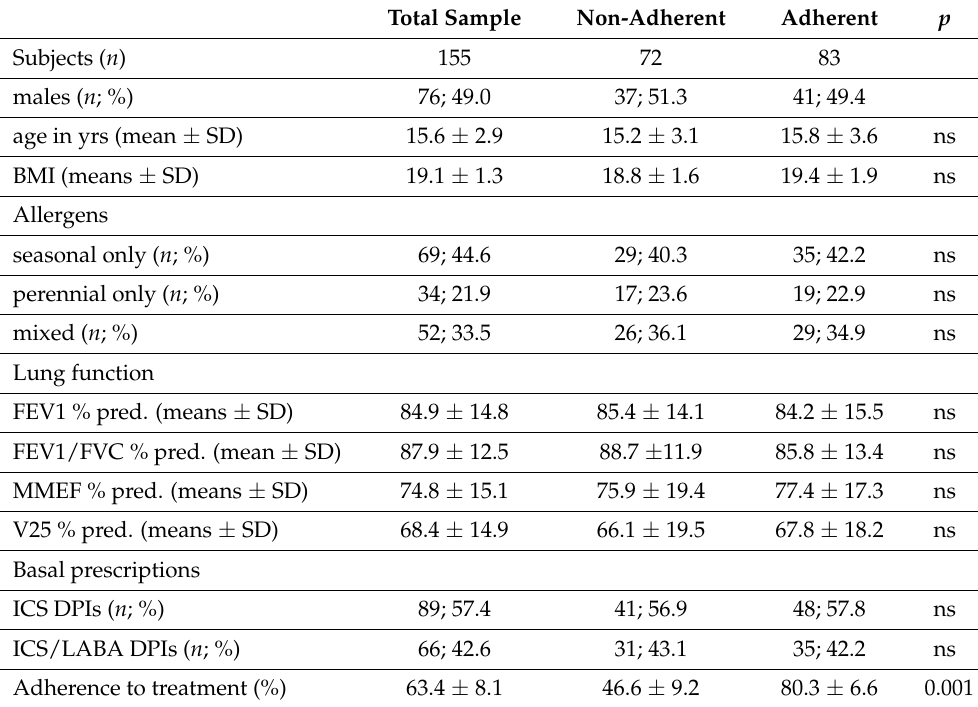
Table 1. General characteristics of the